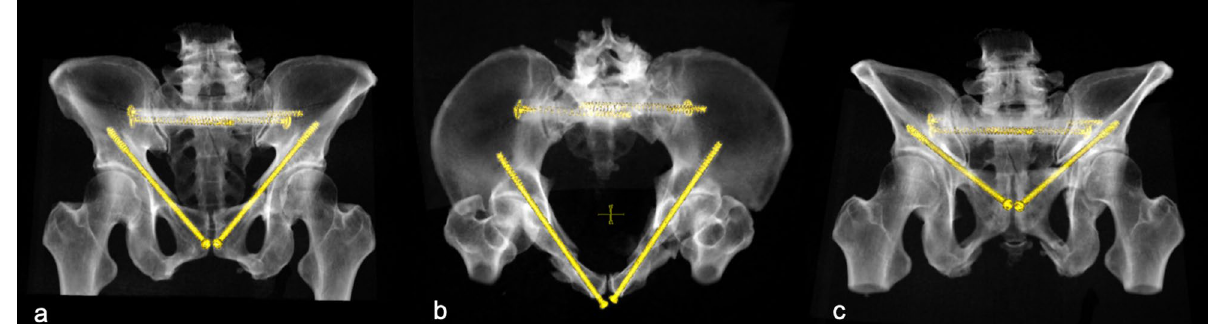
Figure 1. Bilateral retrograde transpubic screw fixation in a patient pelvic ring fracture after traffic accident (a) ap view (b) inlet view (c) outlet view. This figure was generated using the software Sectra PACS (Version 22.1, Linköping, Sweden; www. medic al. sectra. com).